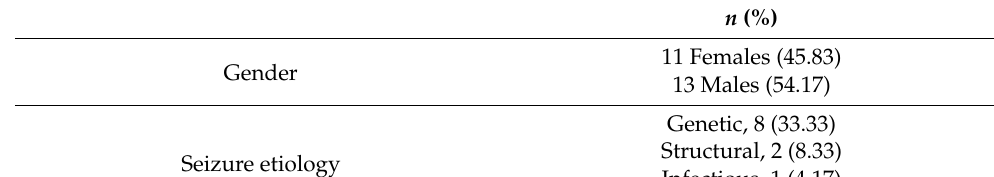
Table 1. Demographic, clinical characteristics and drop-out